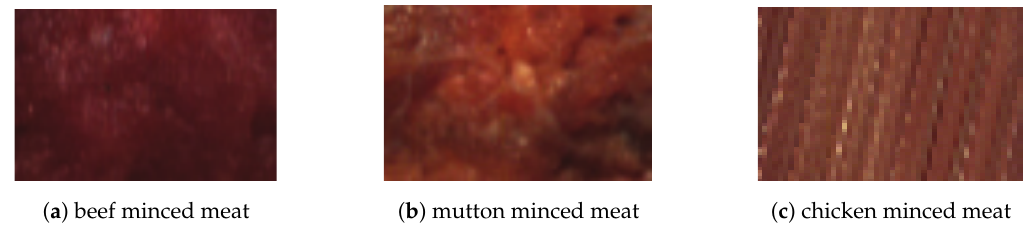
Figure 3. Generated Regions of Interest (ROIs) for primary minced meat types. ( a ) Beef minced